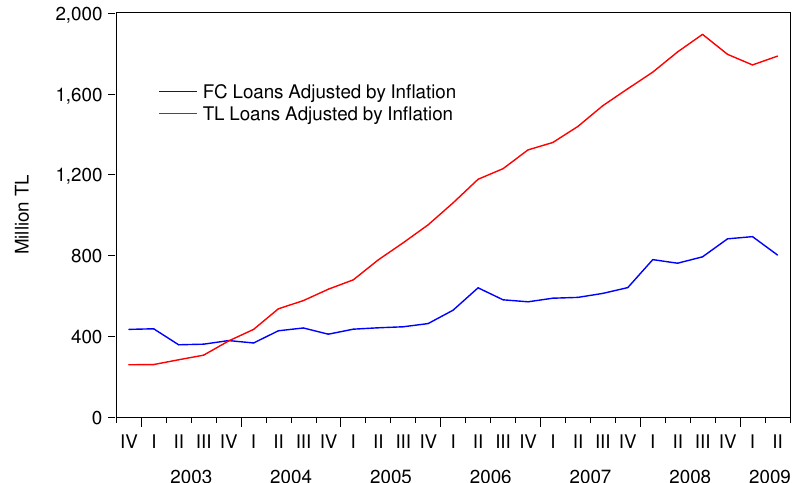
Figure 3. Foreign currency and Turkish lira loans adjusted for inflation.